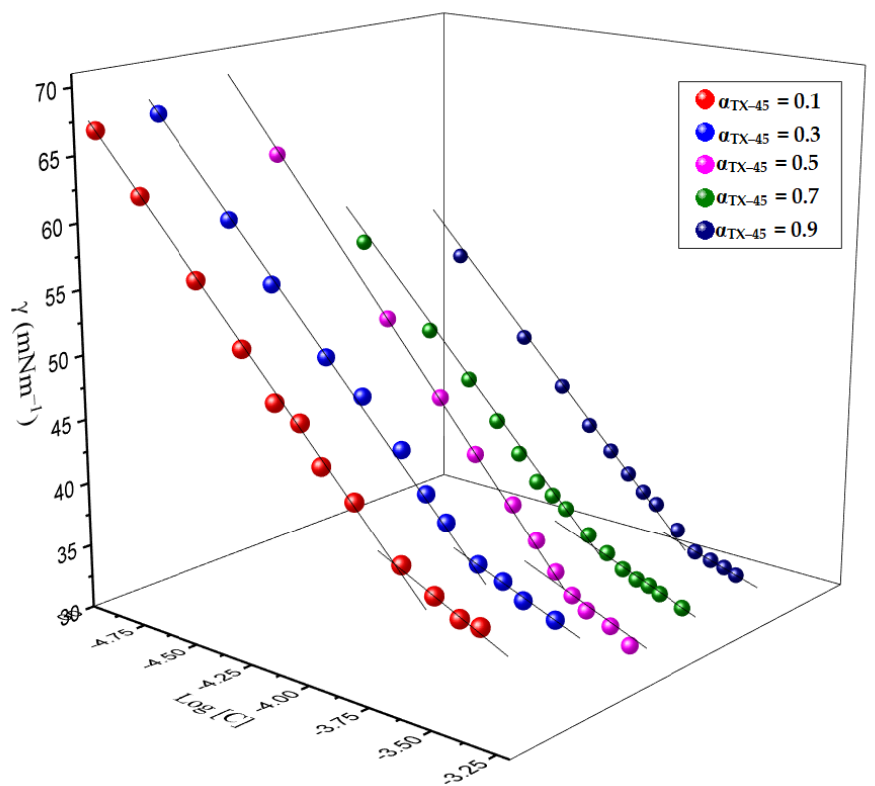
Figure 2. Tensiometric plots of surface tension ( γ ) vs. log amphiphile concentration [ C ] at 298.15.